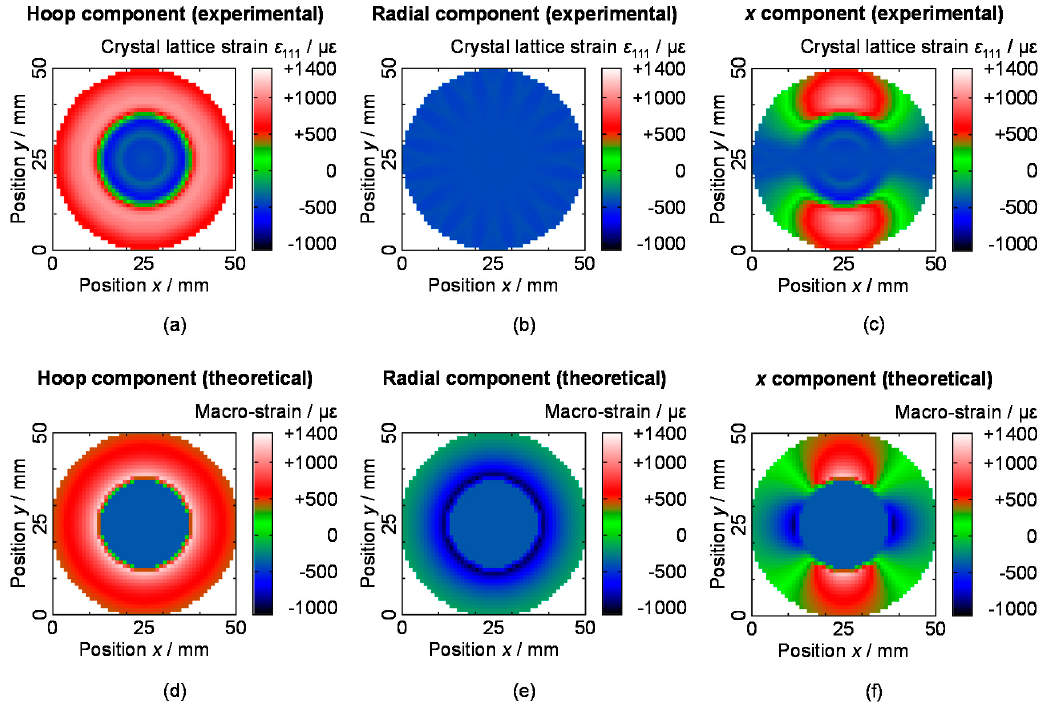
Figure 18. Macro-strain tomography obtained by the ML-EM based tensor CT algorithm: ( a ) hoop component, ( b ) radial component and ( c ) x -direction component, with ( d – f ) their theoretical values [54].